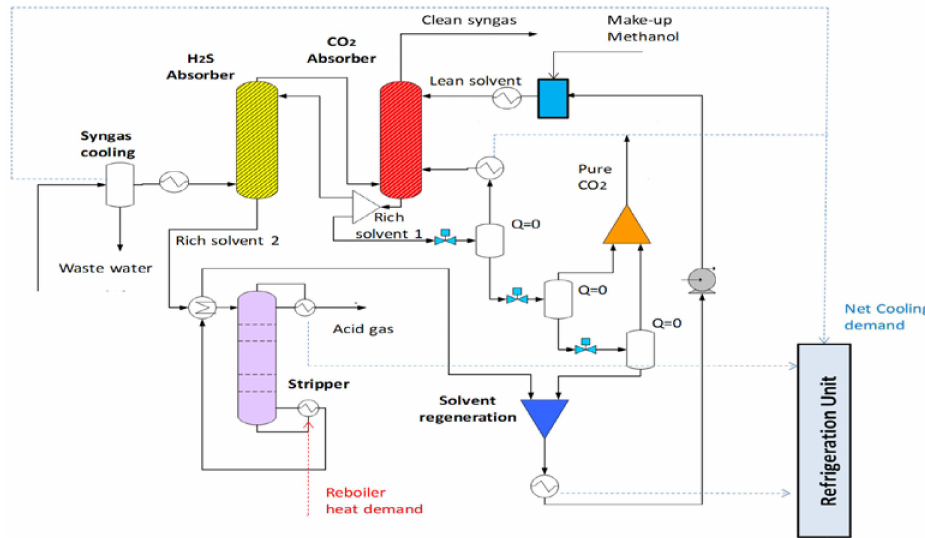
Figure 5. Rectisol unit flow